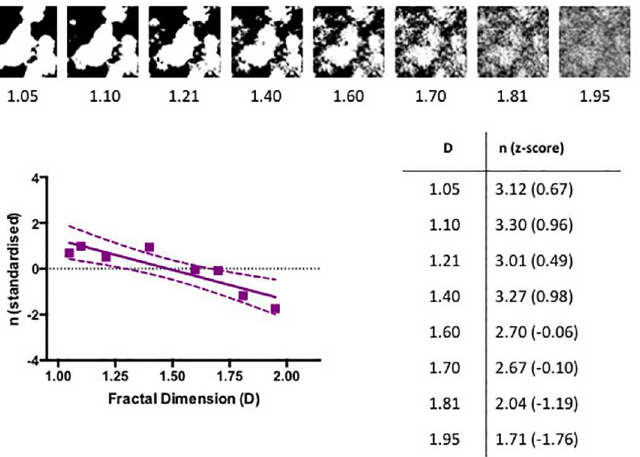
Fig 7. The standardized number of reported percepts, n , induced by the computer-generated fractal patterns plotted as a function of their D value. One set of computer-generatedimages is illustratedabove the graph. The dotted lines represent the boundariesof 95% confidenceintervals. The inset tabulates the D values of the images along with the corresponding averagenumberof